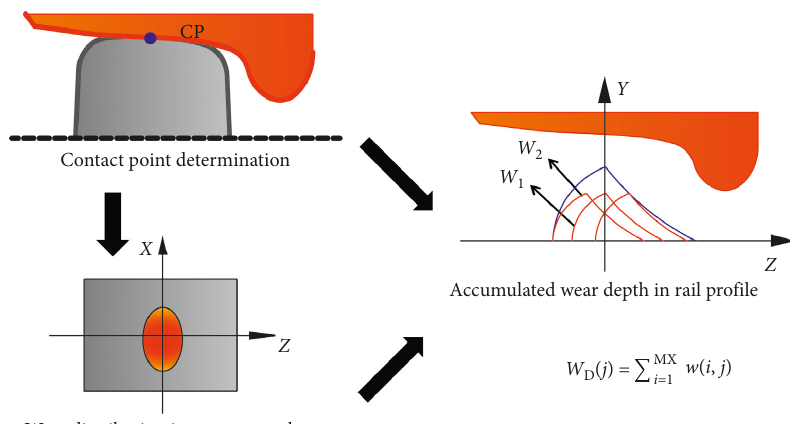
Figure 11: Procedure for the simplified wear accumulated